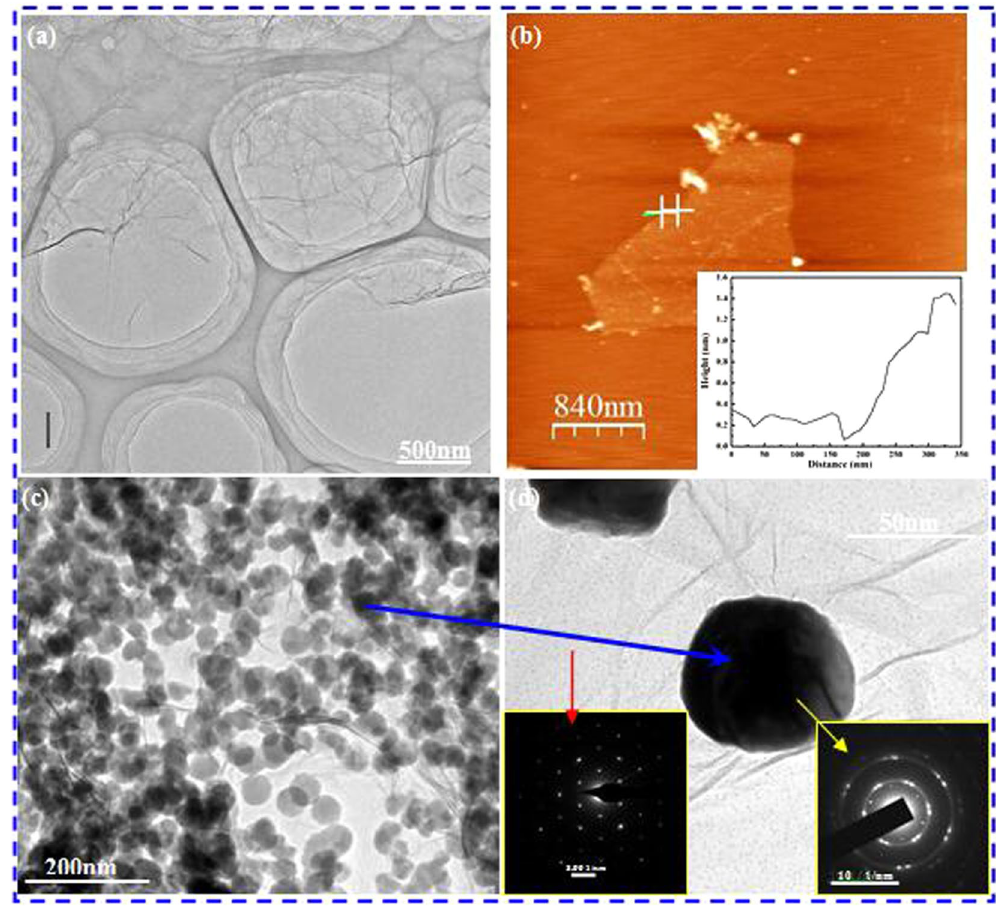
Figure 1. TEM images of ( a ) graphene fabricated by oxidation reduction process using a green reducing agent. ( b ) AFM image of prepared graphene in Fig. 1(a) and the inset height profile shows that the thickness of graphene is ~1.5 nm. ( c ) Cu coated graphene (Cu@Gr) prepared by electroless plating method, and ( d ) a high-magnification image of Cu@Gr powder (inset is selective area diffraction patterns of Cu and graphene,